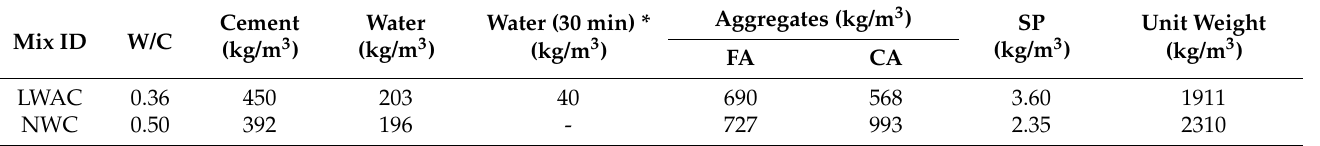
Table 4. Mix proportions of the concrete